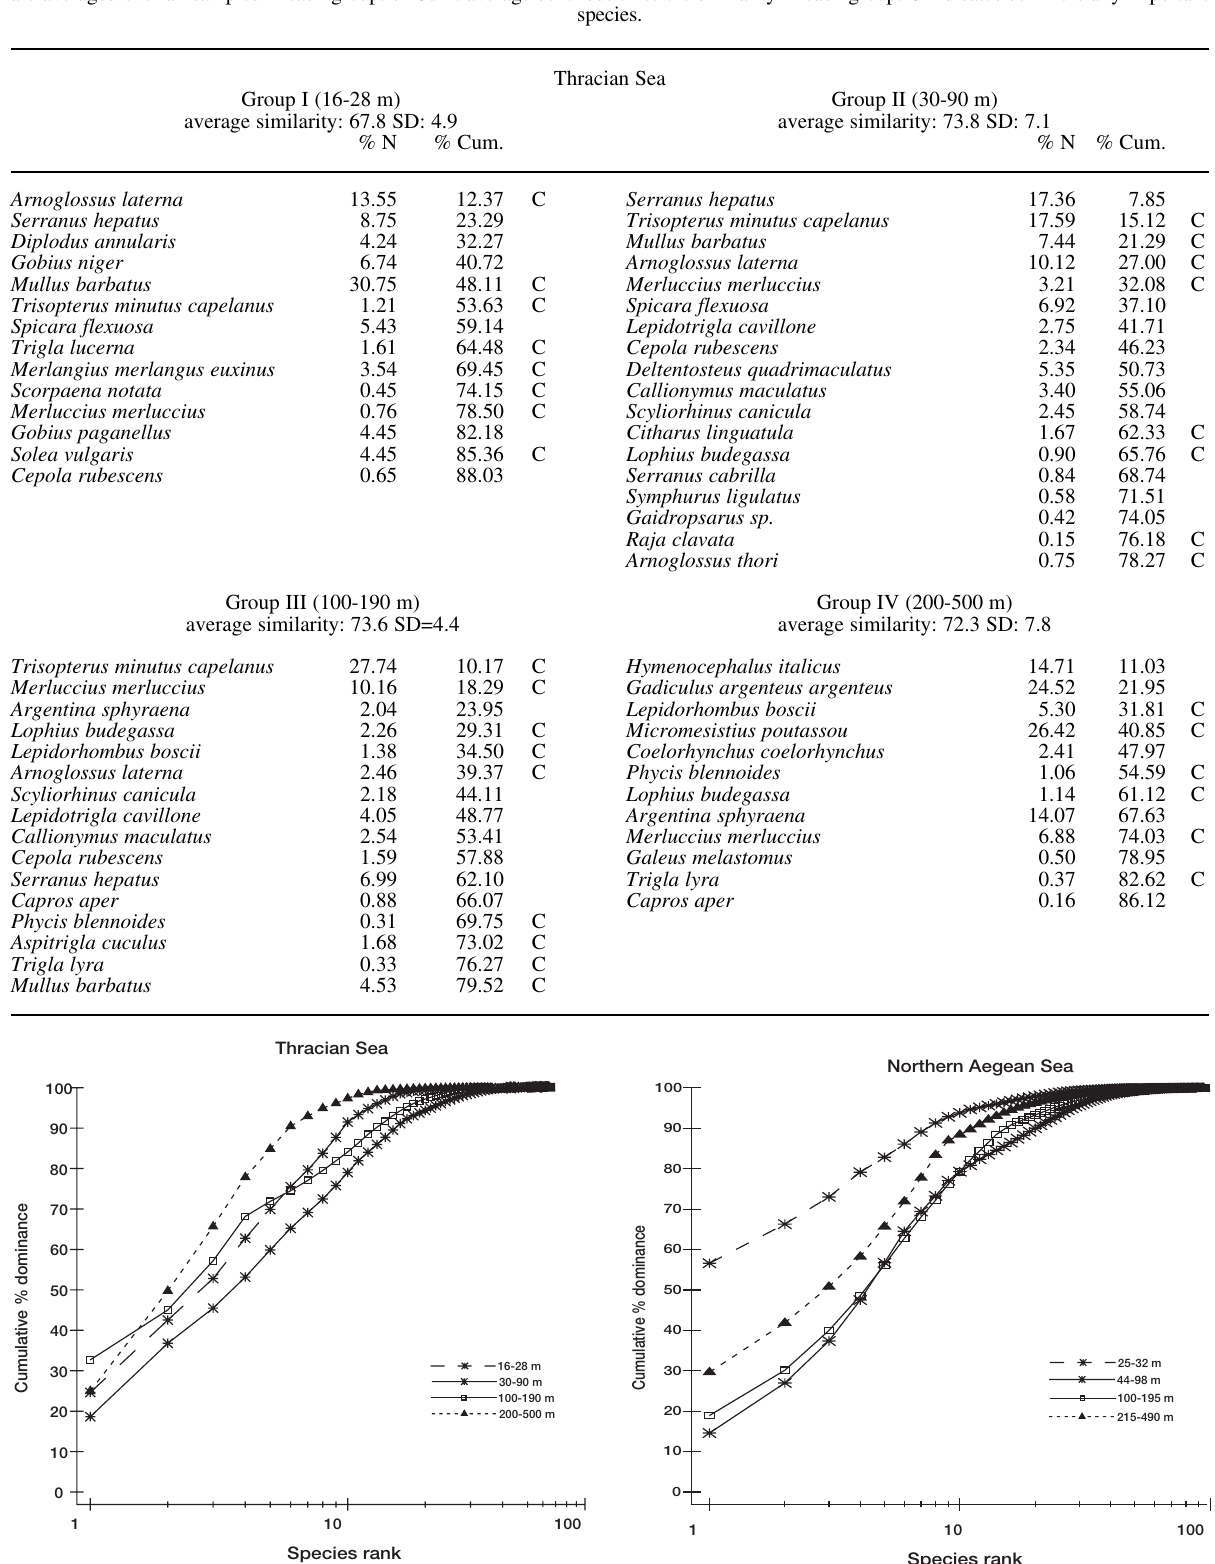
Fig. 4 . – Comparison of k -dominance curves for the demersal fish communities between the four station-groups from the Northern Aegean and Thracian